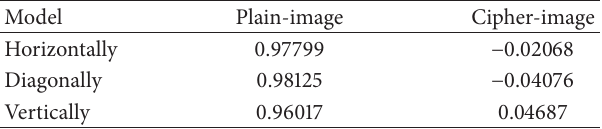
Table 3: Time test